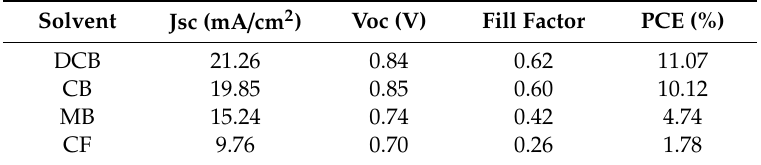
Figure 11. Current density–voltage (J–V) characteristics of the perovskite solar cells (PSCs) based on various ETL solvents. Table 2. Photovoltaic characteristics of PSCs based on various solvents for the ETL.